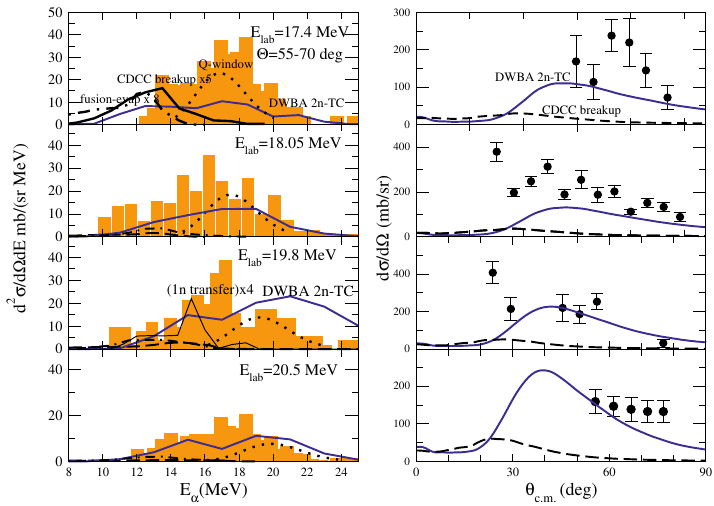
Figure 4. Energy and angular distributions of the alpha particles produced in the 6 He + 120 Sn collision. See ref.